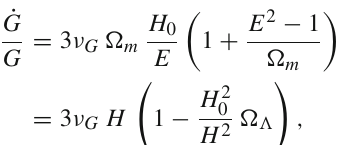
close to each other. In such case both could be of order 10 −